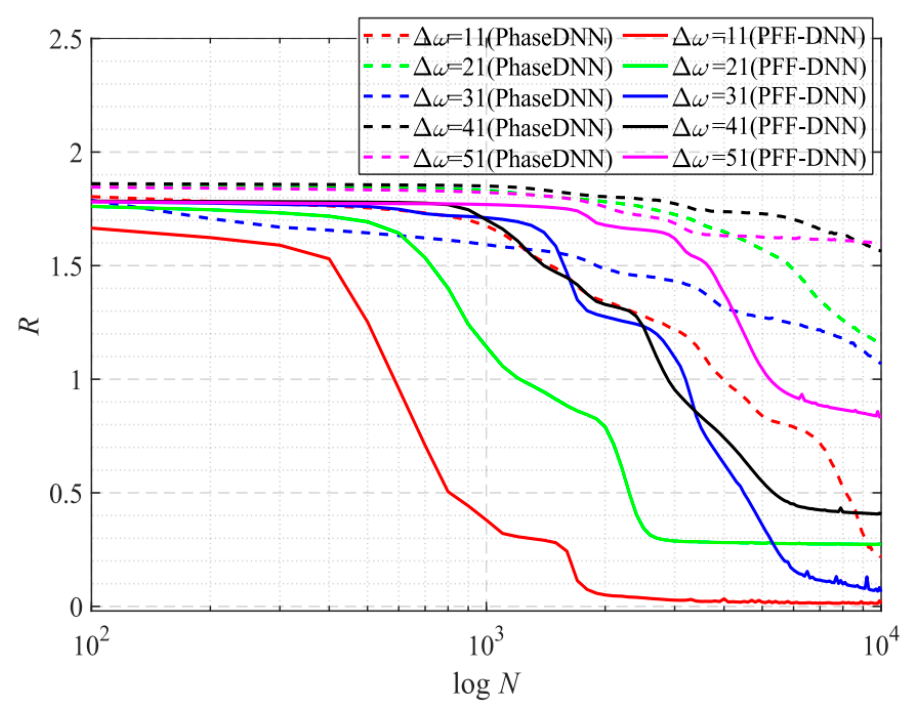
Figure 23. The influence of Δ ω on the convergence process.